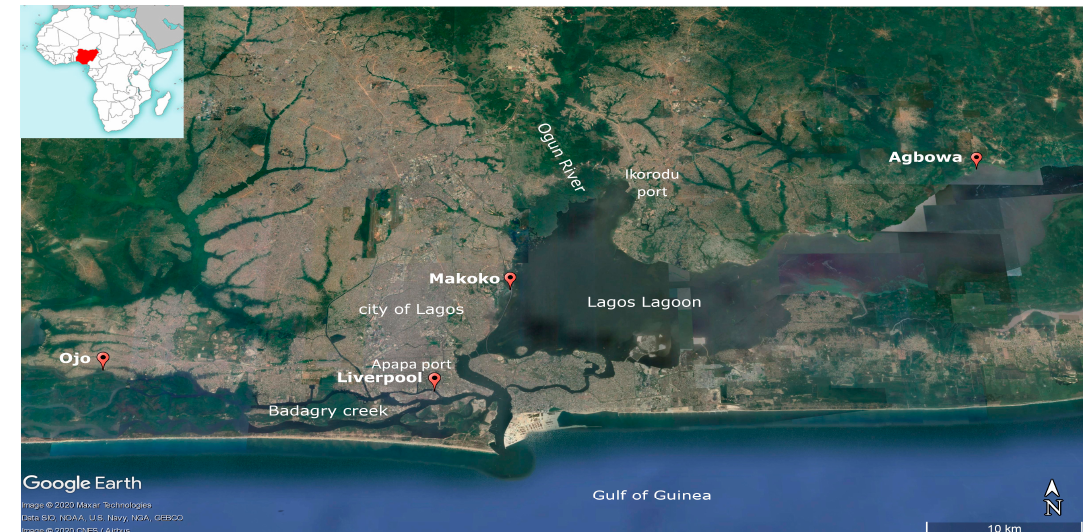
Figure 1. Location of the study area. Sampling sites in the Lagos Lagoon and the Badagry creek (source: Google Earth pro 2020).